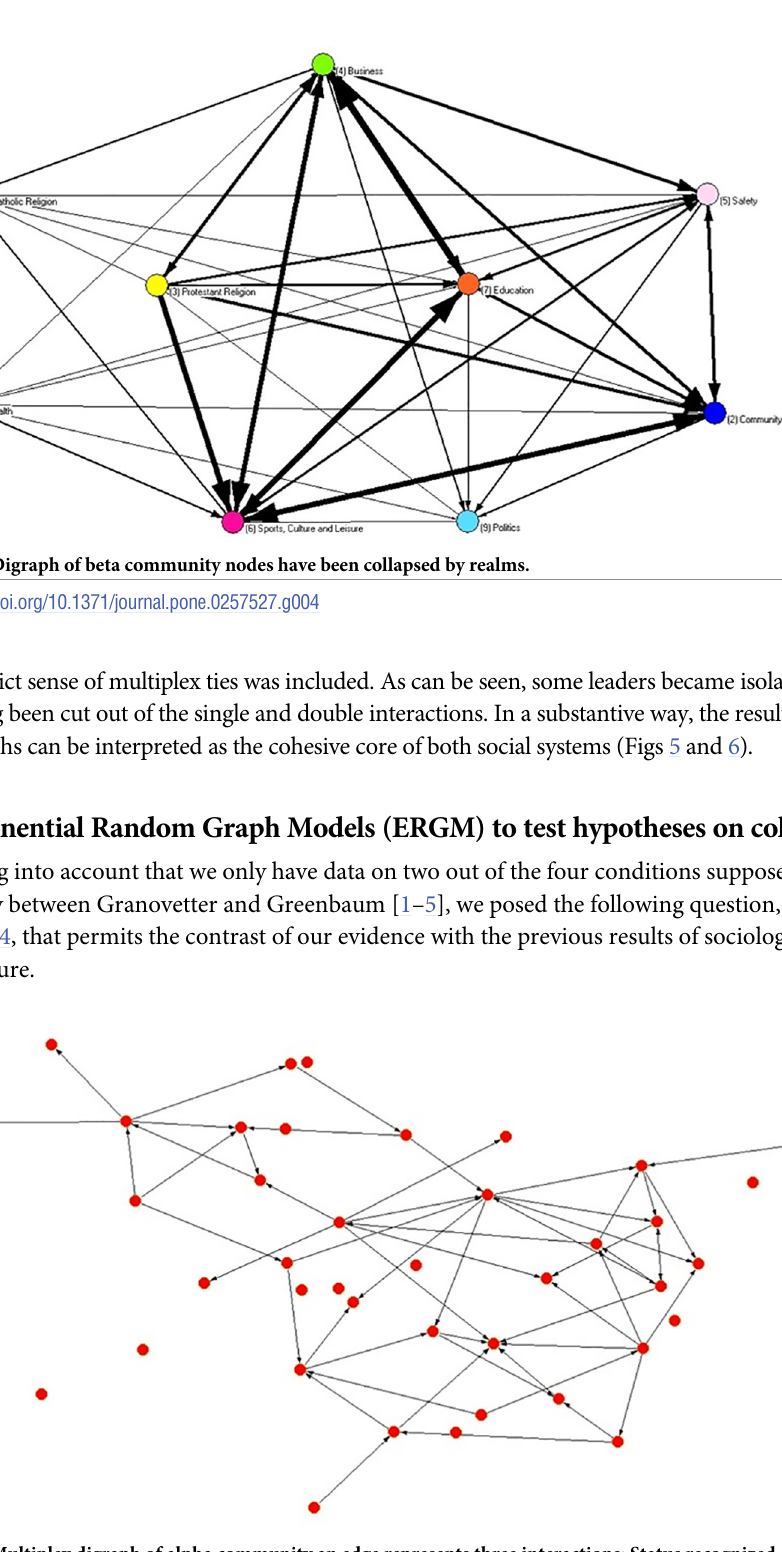
Fig 5. Multiplex digraph of alpha community an edge represents three interactions: Status recognized, exchange of useful information and collaboration.